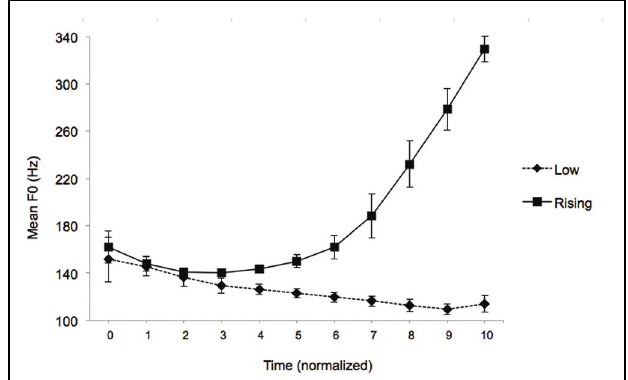
FIGURE 1 | Mean F0 (Hz) as a function of time. F0 was averaged across the eight exemplars used in the low and the rising categories. Stimulus duration is normalized across